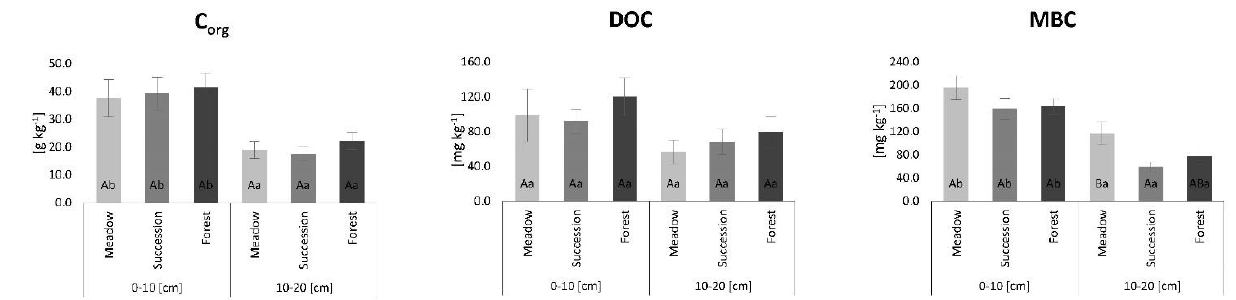
Figure 2. Content of total organic carbon (C org ), dissolved organic carbon (DOC) and microbial biomass carbon (MBC) in soils. The lowercase letters indicate differences between examined soil layers for individual land-use variants, while uppercase letters show differences between land-use variants separately for the 0–10 and 10–20 cm soil layers (Tukey post hoc test, p < 0.05). Standard error is reported as bars.